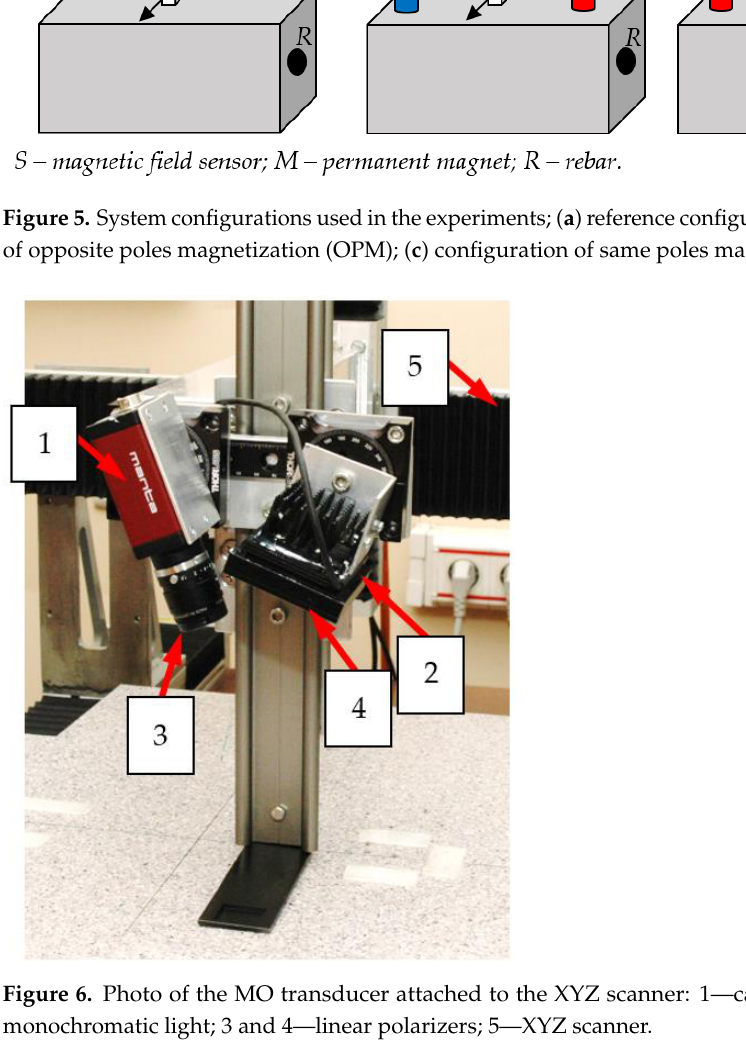
Figure 6. Photo of the MO transducer attached to the XYZ scanner: 1—camera; 2—the source of monochromatic light; 3 and 4—linear polarizers; 5—XYZ scanner. The magnetic field sensor is an essential part of the system. Magnetoresistive (MR) and Hall effect sensors are of the greatest industrial importance among the magnetic field sensors. The Hall effect components account for approximately 85% of the world’s pro- duction of magnetic sensors for DC and low-frequency applications. The MR sensors ac- count for around 10%, and their market share grows [25].